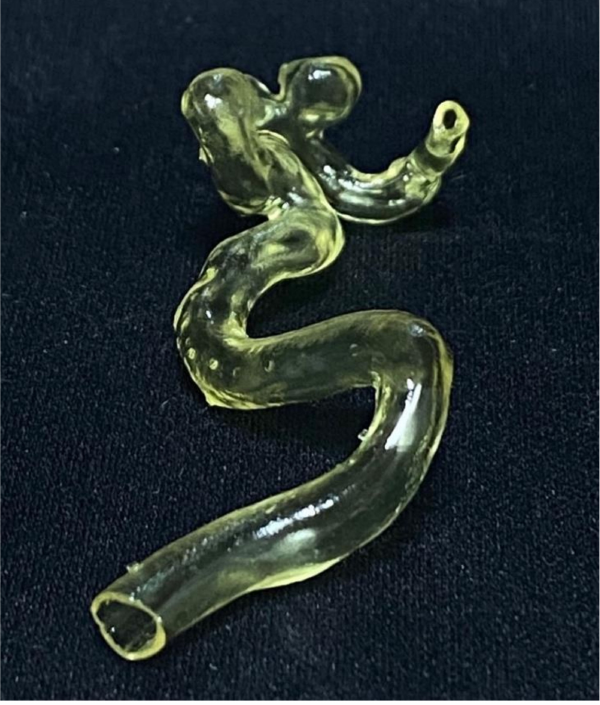
Figure 6. Hollow 3D printed model of ICA with an aneurysm on an ophthalmic